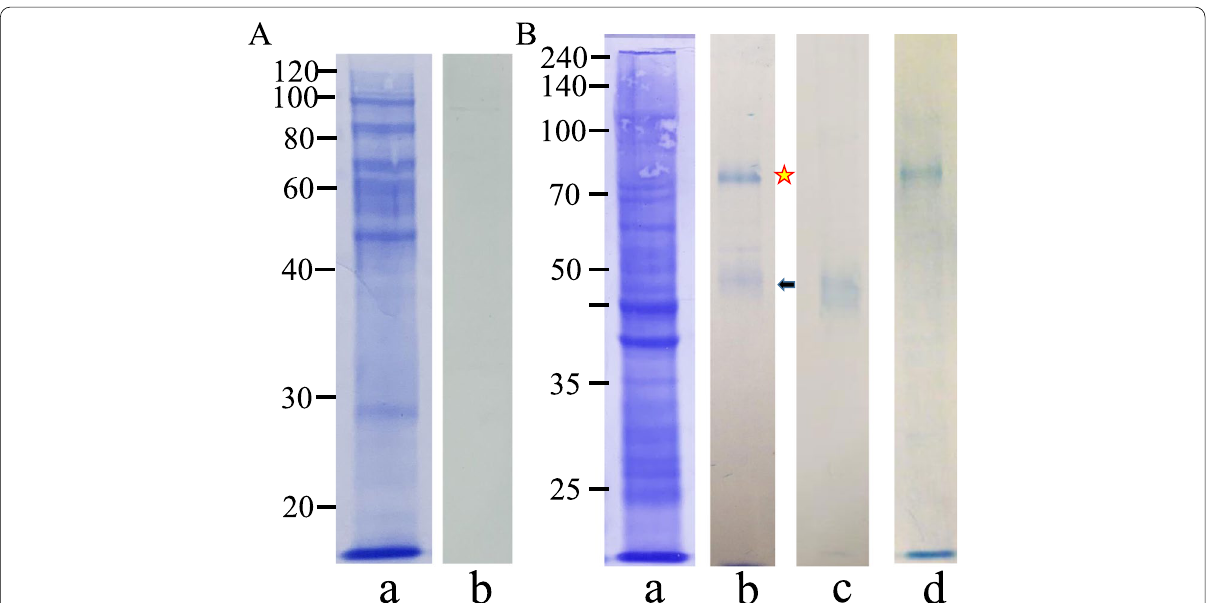
Fig. 5 Specificity of the mZPC5 antibody and detection of mZPC5 in female tissue extracts. SDS-PAGE results are shown for liver (A) and ovary (B) tissue extracts of spawning females. A: the 10% SDS-PAGE pattern of CBB-stained proteins in the female liver extracts (Aa) and the associated proteins that were immunoreactive to the anti-mZPC5 antibody (Ab). B: the 8% SDS-PAGE pattern of CBB-stained proteins in the female ovary extracts (Ba) and the associated proteins that were immunoreactive to the anti-mZPC5 (Bb), anti-Chg.L (Bc), and anti-Chg.H (Bd) antibodies, respectively. Symbols – yellow star: ~ 74-kDa proteins reactive to the anti-mZPC5 anyibody, black arrow: ~ 50-kDa proteins reactive to the anti-mZPC5